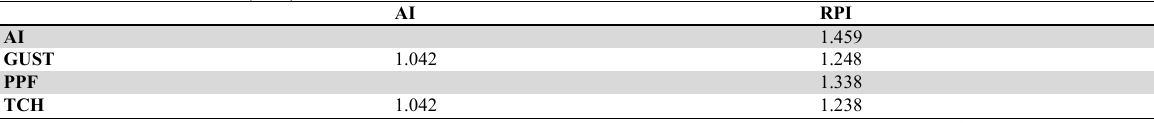
Variance Inflation Factors